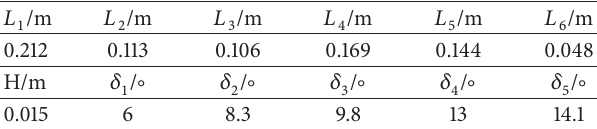
Table 1: Geometric parameters of the hypersonic